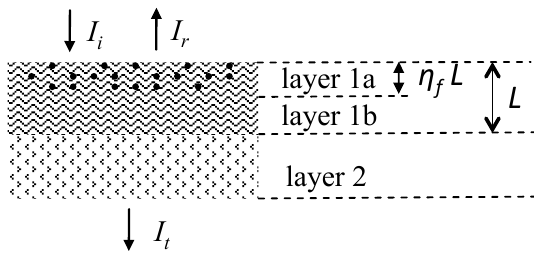
Figure 2. Transmitted and reflected intensities of a filter. The filter consists of two parts: the fiber layer of thickness L and the backing layer. Particles are collected homogeneously in the upper part of the fiber layer (layer 1a) with the relative thickness η f . Layer 2 is the backing layer for the mechanical stability of the filter. In this configuration layer 1 is illuminated directly by the light source. The arrows indicate the incident, reflected, and transmitted radiant flux,